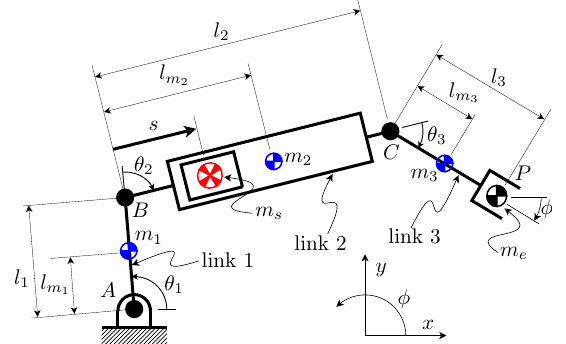
Fig. 1: Serial manipulator with internal redundancy in link 2 . The Figure 1. Serial manipulator with internal redundancy in link 2. location of mass m s can be changed without altering the position The location of mass m s can be changed without altering the posi- of the end effector (point p ). tion of the end e ff ector (point p ).